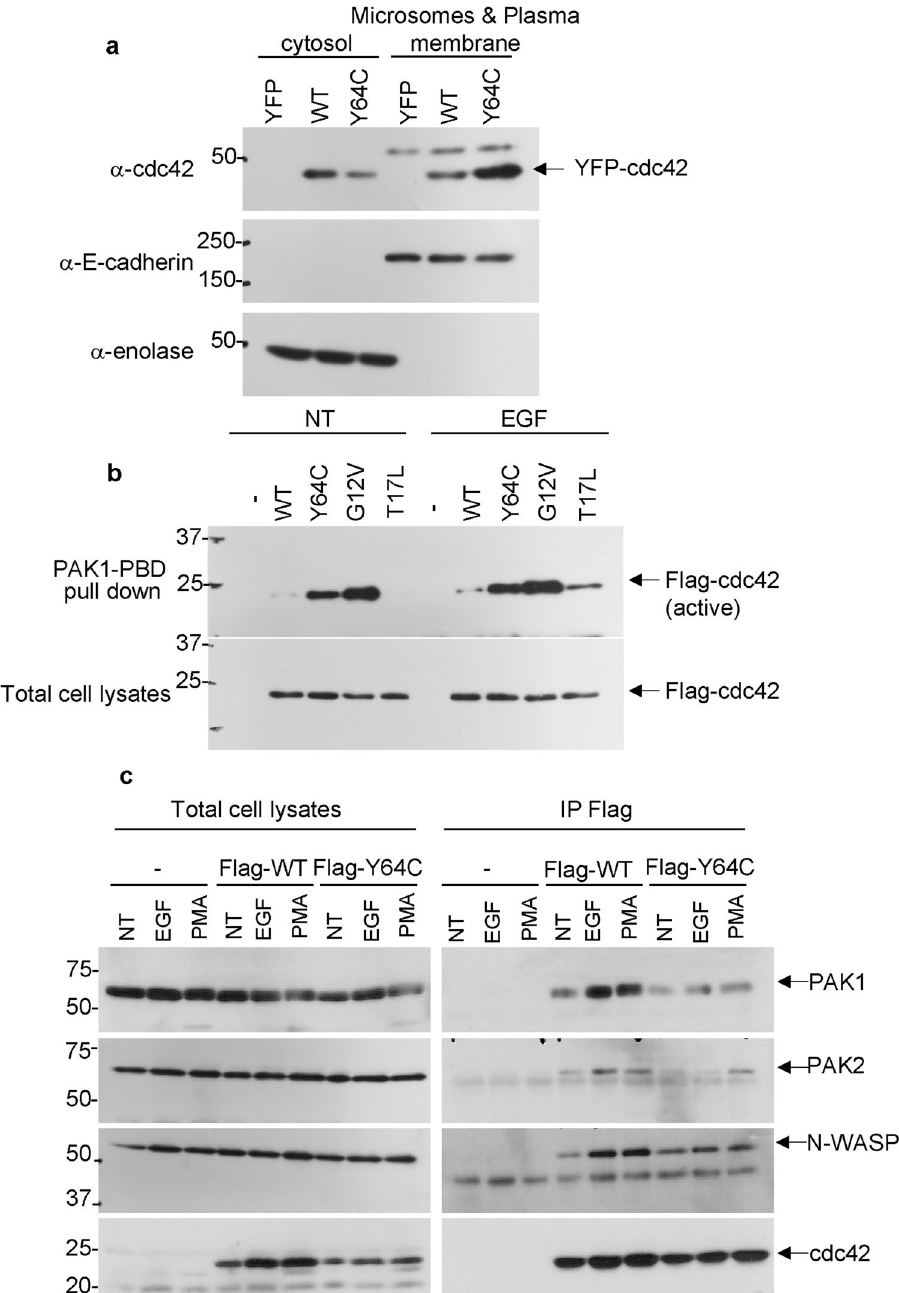
Figure 2. Y64C facilitated both membrane localization and activity, and affected downstream signaling. ( a ) After EYFP-tagged Cdc42 was introduced into HEK293 cells, cytosolic and membrane (microsome and plasma membrane) fractions were separated by ultracentrifugation. Each fraction was subjected to SDS-PAGE followed by Western blotting using the indicated antibodies. ( b ) EYFP-tagged WT or Y64C was introduced into HEK293 cells and equal amounts of proteins were subjected to pull-down assay using PAK-RBD to isolate GTP-bound Cdc42. Cell lysates were reacted with anti-cdc42 antibody. ( c ) Flag-tagged WT or Y64C was recovered using anti-Flag agarose and co-IP assay was performed using the indicated antibodies. Full length blots are presented in Supplemental Fig.